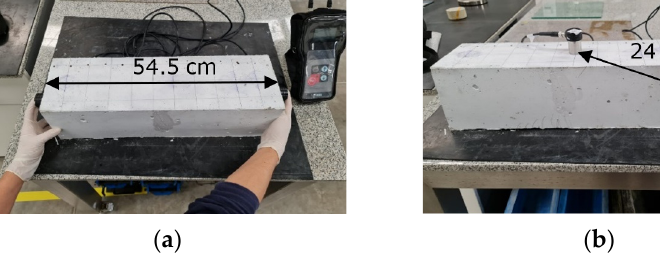
Figure 3. Ultrasound configurations: ( a ) direct method, ( b ) semi-direct method, ( c ) indirect